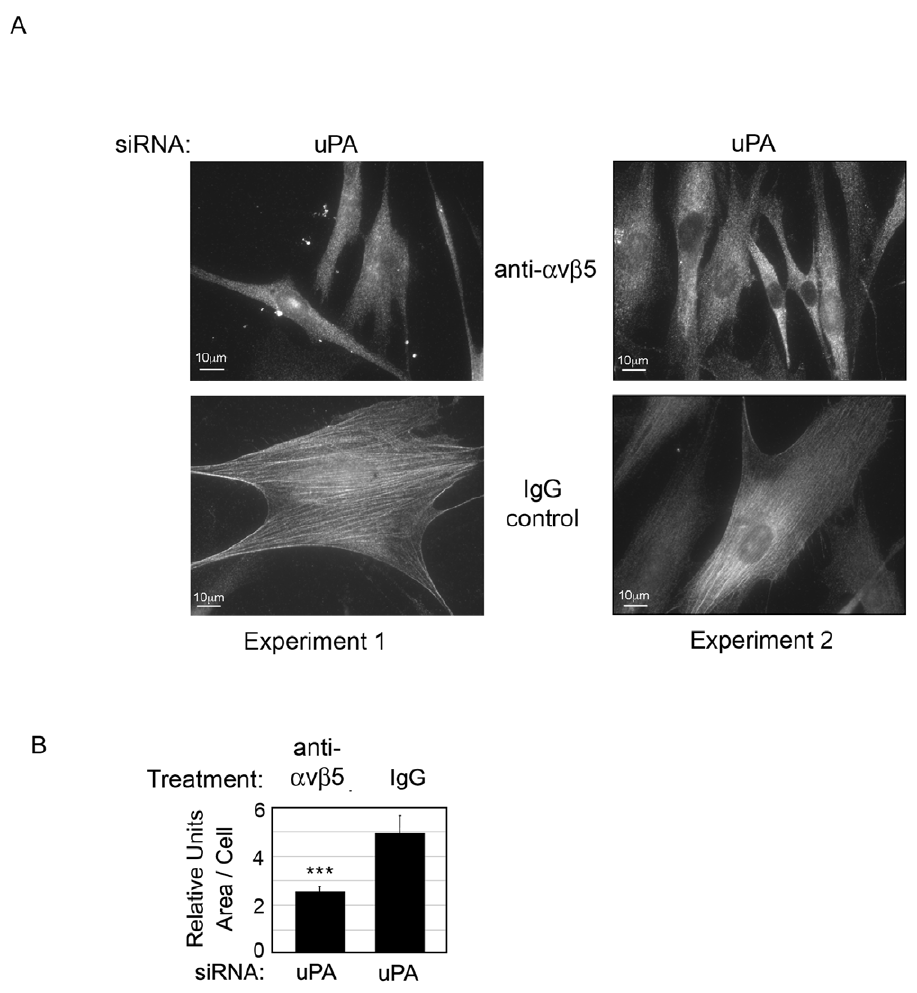
Figure 5. Treatment with anti- a v b 5 antibody reverses the effect of uPA-silencing. HCFs were transfected with uPA siRNA and seeded with a blocking a v b 5 antibody or matched IgG. After 24 hours (A) cells were immunostained with anti- a -SMA antibody. Bar=10 um. Images are from two independent experiments. (B) Metamorph analysis quantified changes in average cell size in each condition. ***p value , 0.001. N=3 for each